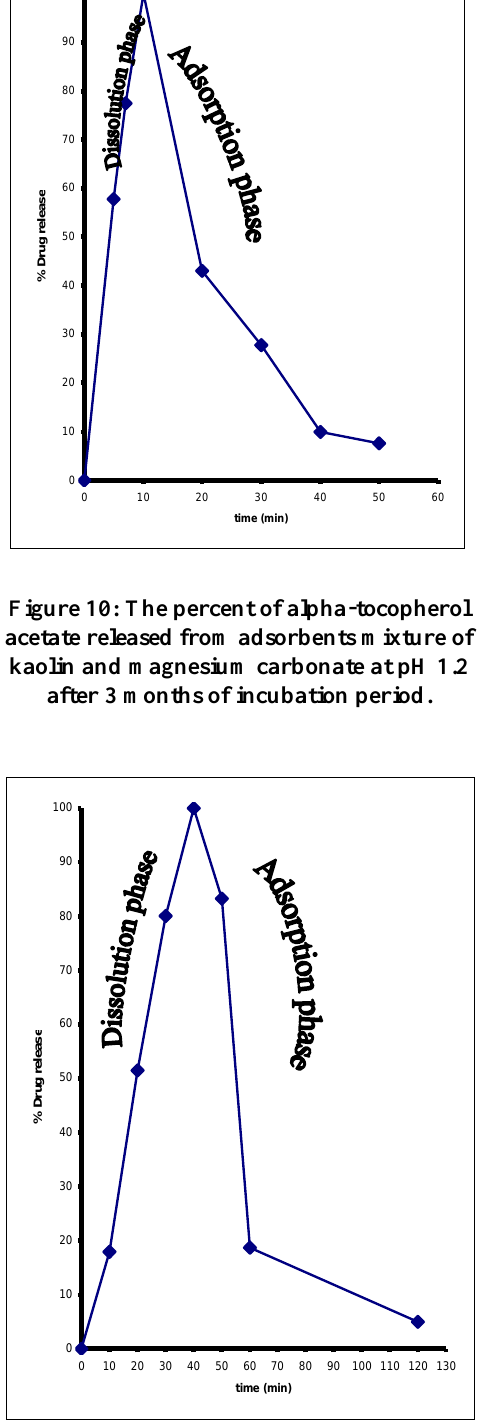
Figure 12: Adsorption of drug on various adsorbents after 3 months of